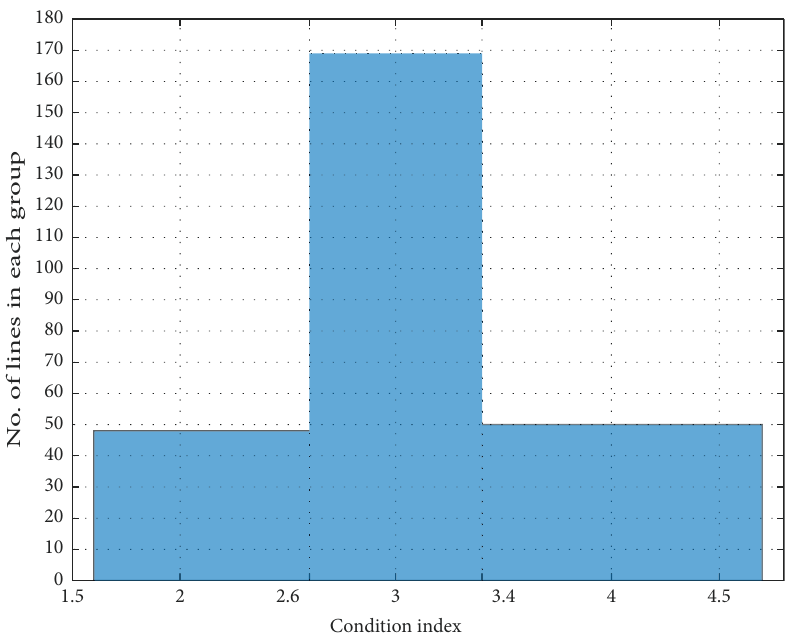
Figure 10: Histogram curve of lines condition